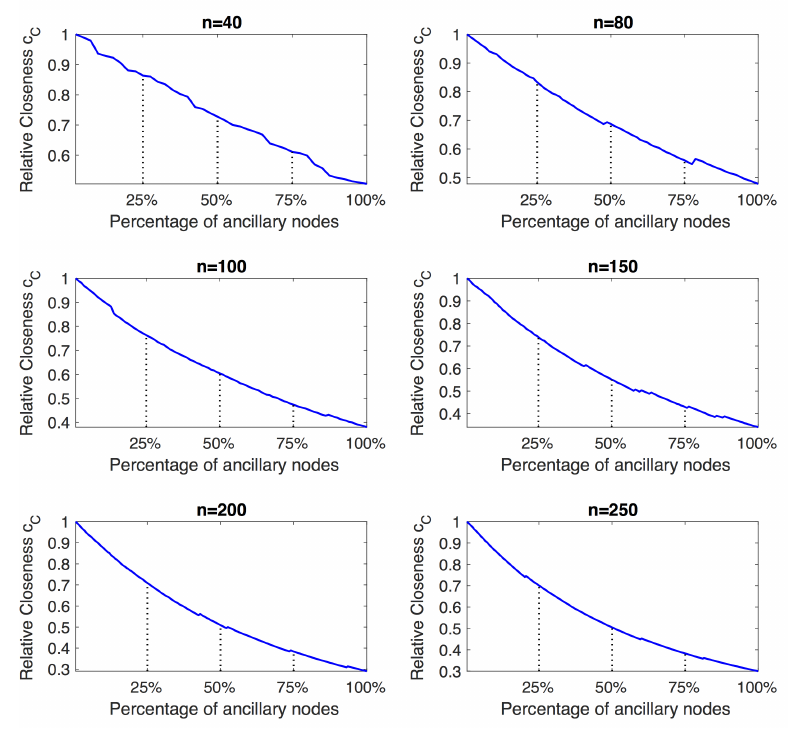
Fig. 6. Relative Closeness network